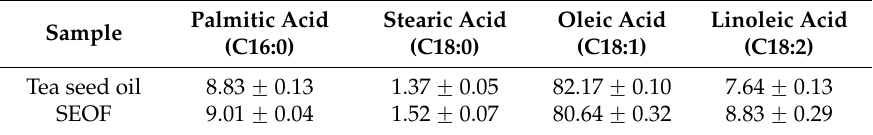
Table 2. Levels (%) of fatty acid composition obtained from tea seed oil and SEOF.